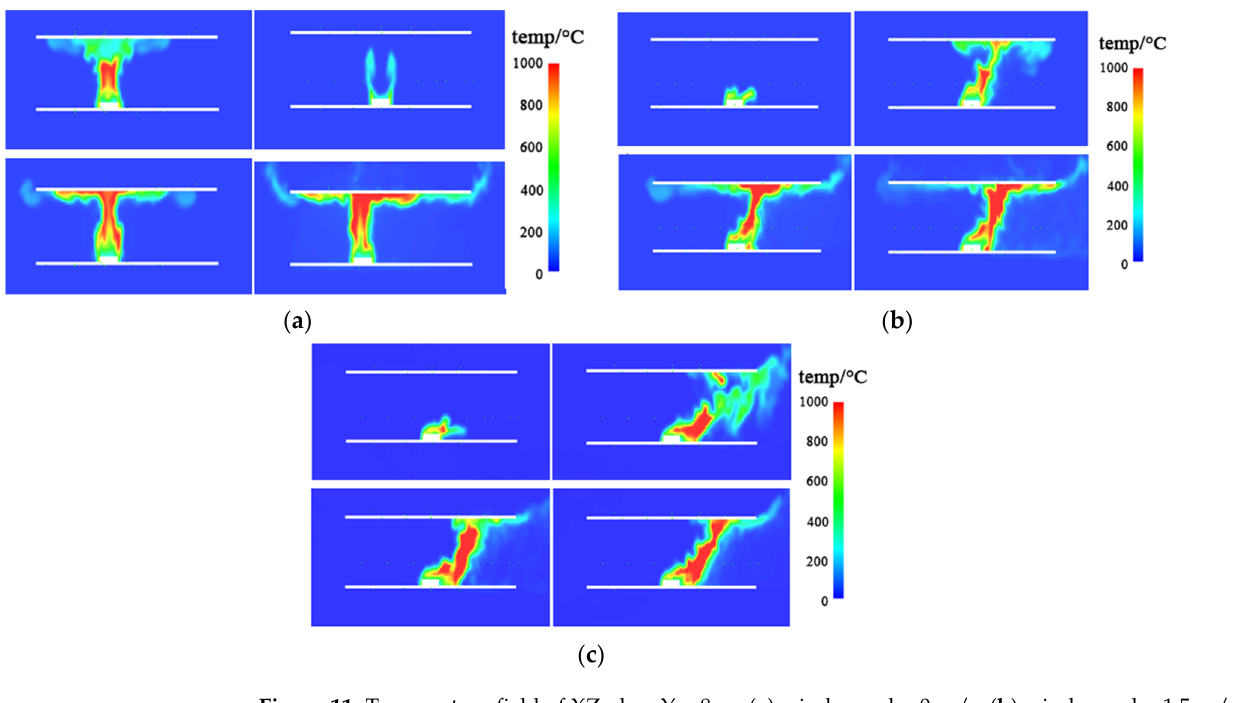
Figure 11. Temperature field of XZ plan, Y = 8 m: ( a ) wind speed = 0 m/s; ( b ) wind speed = 1.5 m/s; ( c ) wind speed = 3 m/s.